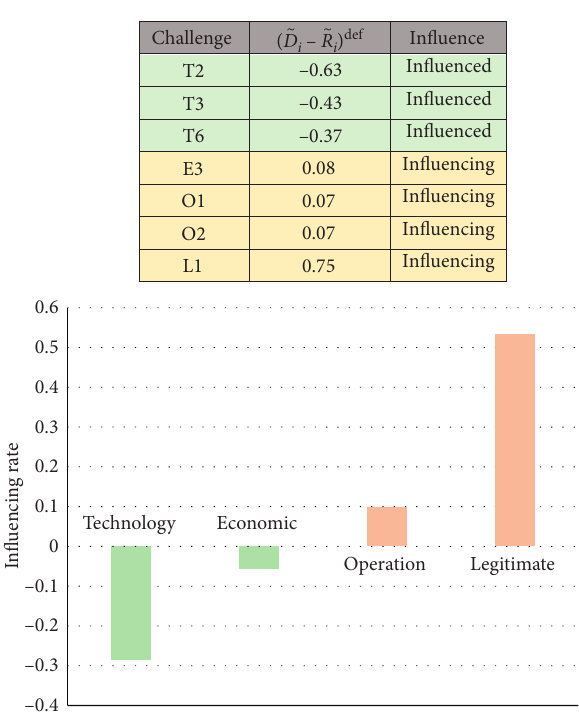
Figure 9: General state of each